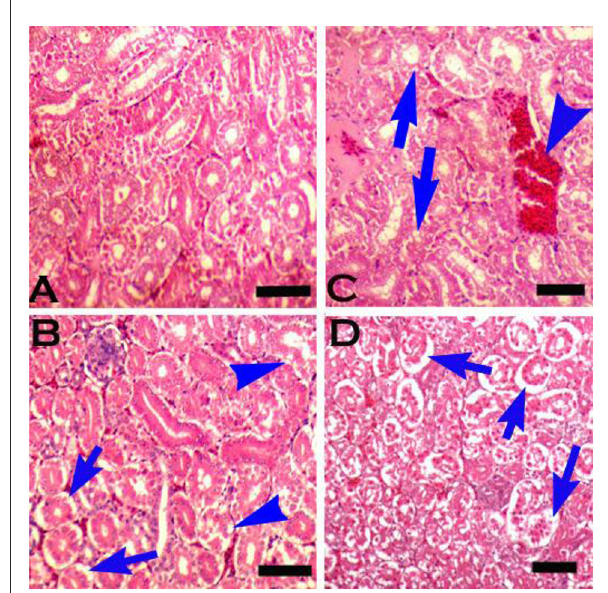
FIGURE7 Photomicrograph of the kidneys of broiler chicks stained with H&E (scale bar = 50): (A) control group showing normal histology, (B) group 2 (chromium treated) showing pyknosis and disintegration of cells from the basement membrane (arrows), and degeneration in the form of vacuolation (arrow heads), (C) group 3 (arsenic treated) showing congestion (arrowhead) and degenerative changes in the form of vacuolation (arrows), and (D) group 6 (chromium + arsenic treated) showing pyknosis and disintegration of cells from the basement membrane